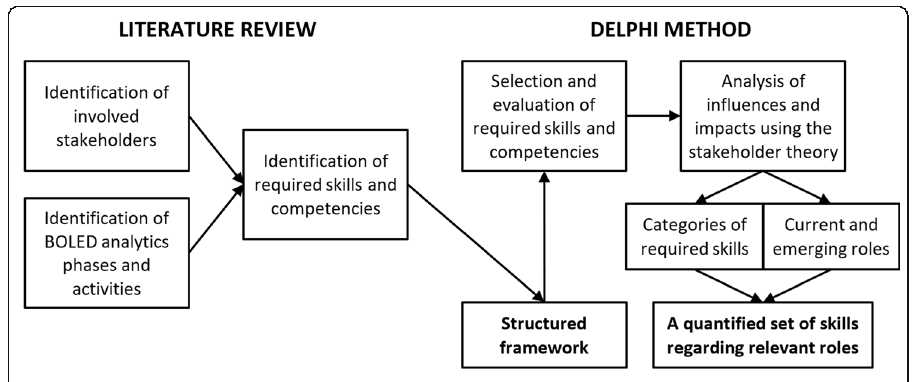
Fig. 2 Steps of the research methodology